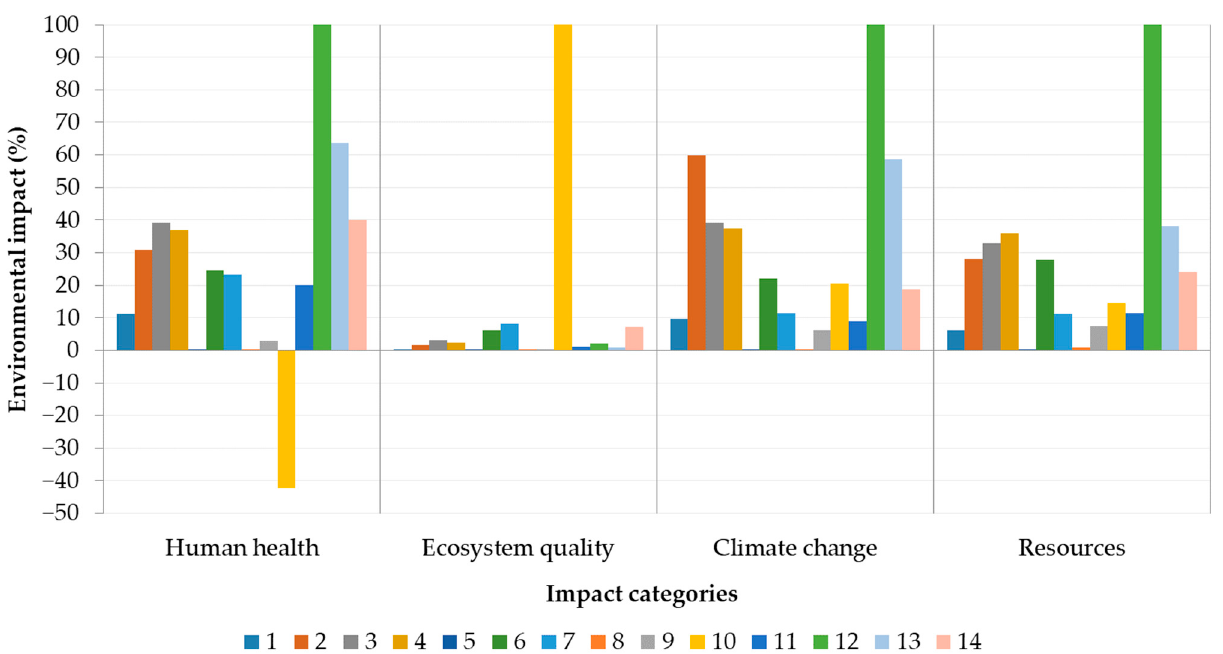
Figure 4. Damage assessment of construction materials within each endpoint impact category (human health, ecosystem quality, climate change and resources). Numbers refer to construction materials listed in Table 3.